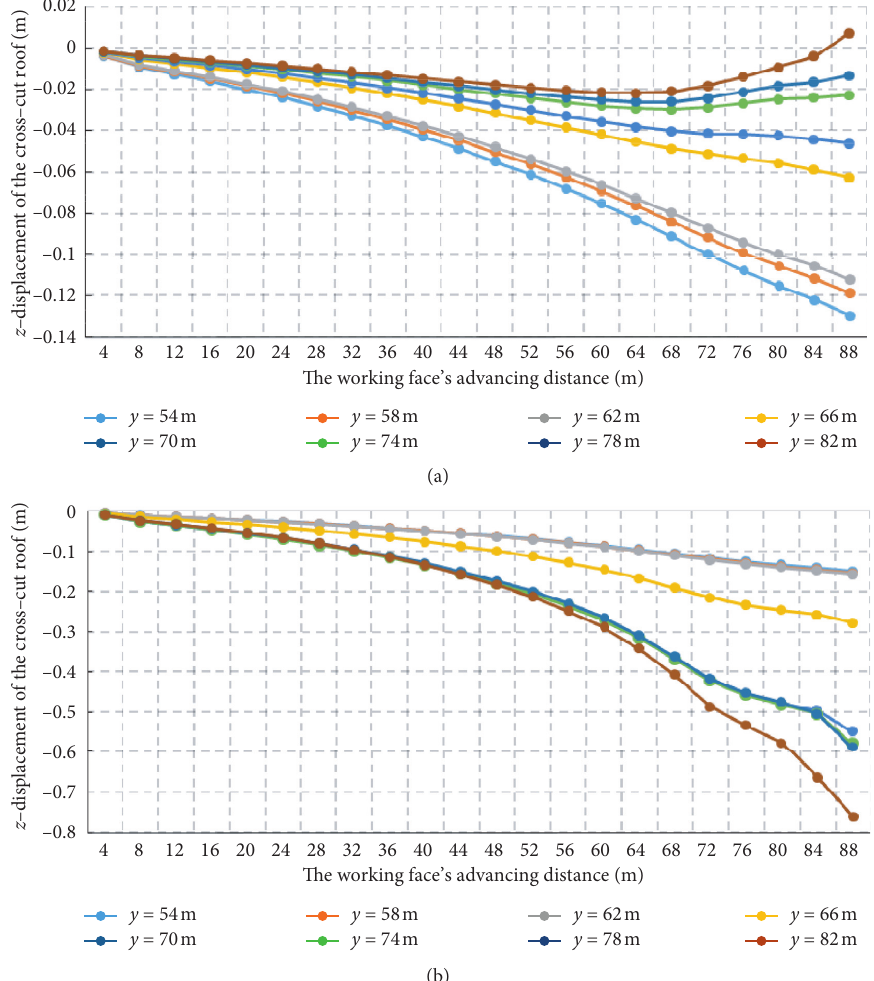
Figure 12: z -displacement of PTR section. (a) z -displacement of PTR section with backfilling. (b) z -displacement of PTR section without